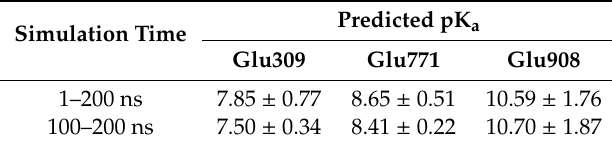
Table 2. Mean values of predicted pK a under the influence of the environment for titrable residues Glu309, Glu771, and Glu908 calculated for the whole (1–200 ns) and the second half (100–200 ns) of the MD